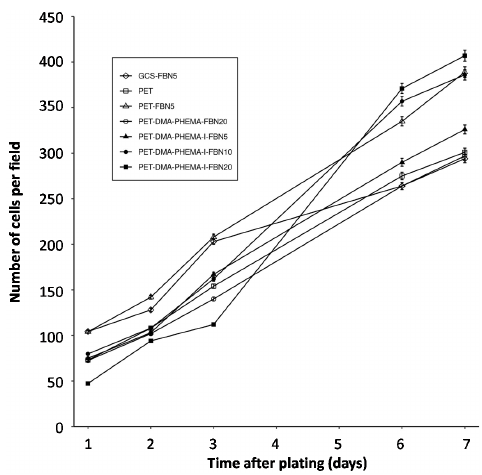
Figure 4. Cell growth on PET membranes. C2C12 myoblastic cells were plated on plastic dishes containing PET substrates subjected to various treatments. The day of plating was defined as day 0. Cells were grown on regular medium supplemented with calf serum and antibiotics. At days 1, 2, 3, 6, and 7 after plating, 5 fields taken at random above PET substrates were visualized under microscope and the number of cells counted. GCS-FBN 5 : glass coverslips coated with 5 µg/mL of fibronectin, PET: untreated PET sheets, PET-FBN 5 : untreated PET membranes coated with 5 µg/mL of fibronectin, PET-DMA-PHEMA-FBN 20 : PET membranes grafted but not treated with CDI, and then coated with 20 µg/mL of fibronectin, PET-DMA-PHEMA-I-FBN x : PET membranes grafted with the DMA, PHEMA, imidazole and reacted with fibronectin at initial concentration x = 5, 10, and 20 µg/mL respectively.